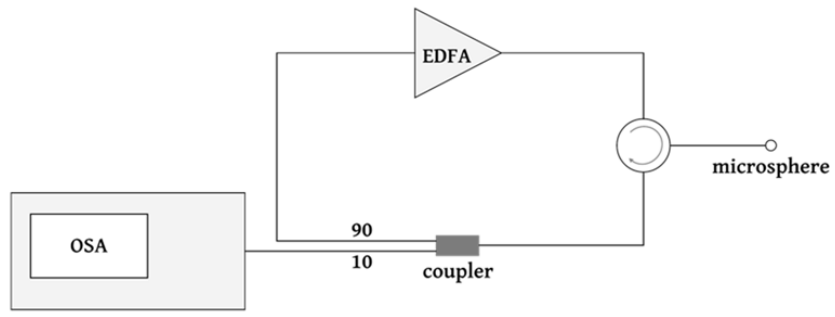
Figure 4. Schematic of the optical setup for random fiber laser operation using the microstadium. OSA—optical spectrum analyzer; EDFA—erbium ‐ doped fiber amplifier.